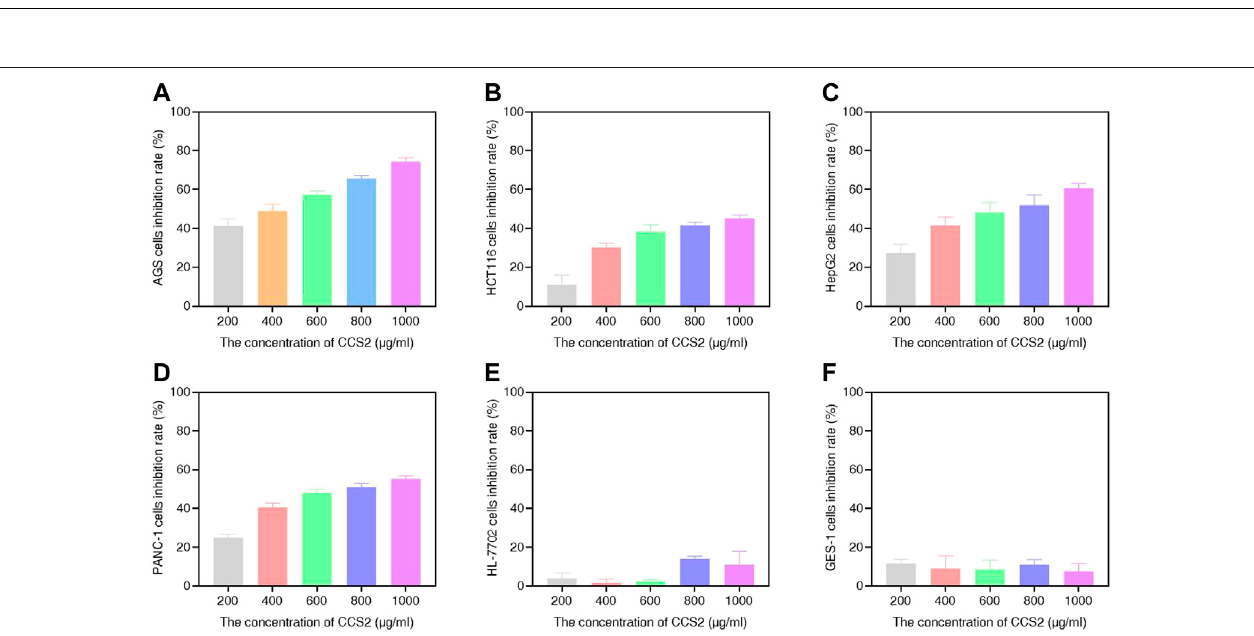
FIGURE2| SuppressiveeffectofCCS2ontheproliferationoffourkindsofdigestivetractdigestivetractcancercells.Theresultswereobtainedaftertreatmentwith CCS2 for 48 h (A – F) CCK-8 results for AGS, HCT116, HepG2, PANC-1, HL-7702 and GES-1 cells. Data are expressed as the average of three independent